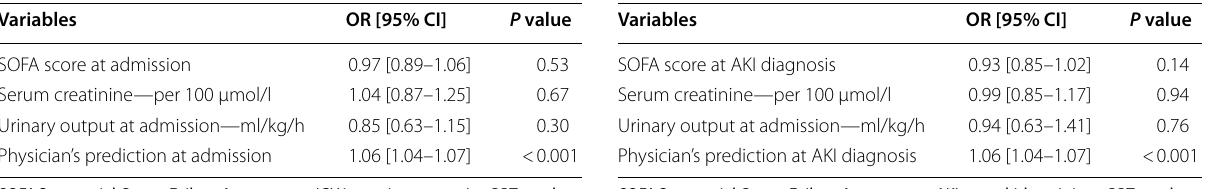
SOFA Sequential Organ Failure Assessment, ICU intensive care units, RRT renal replacement therapy, OR odds ratio